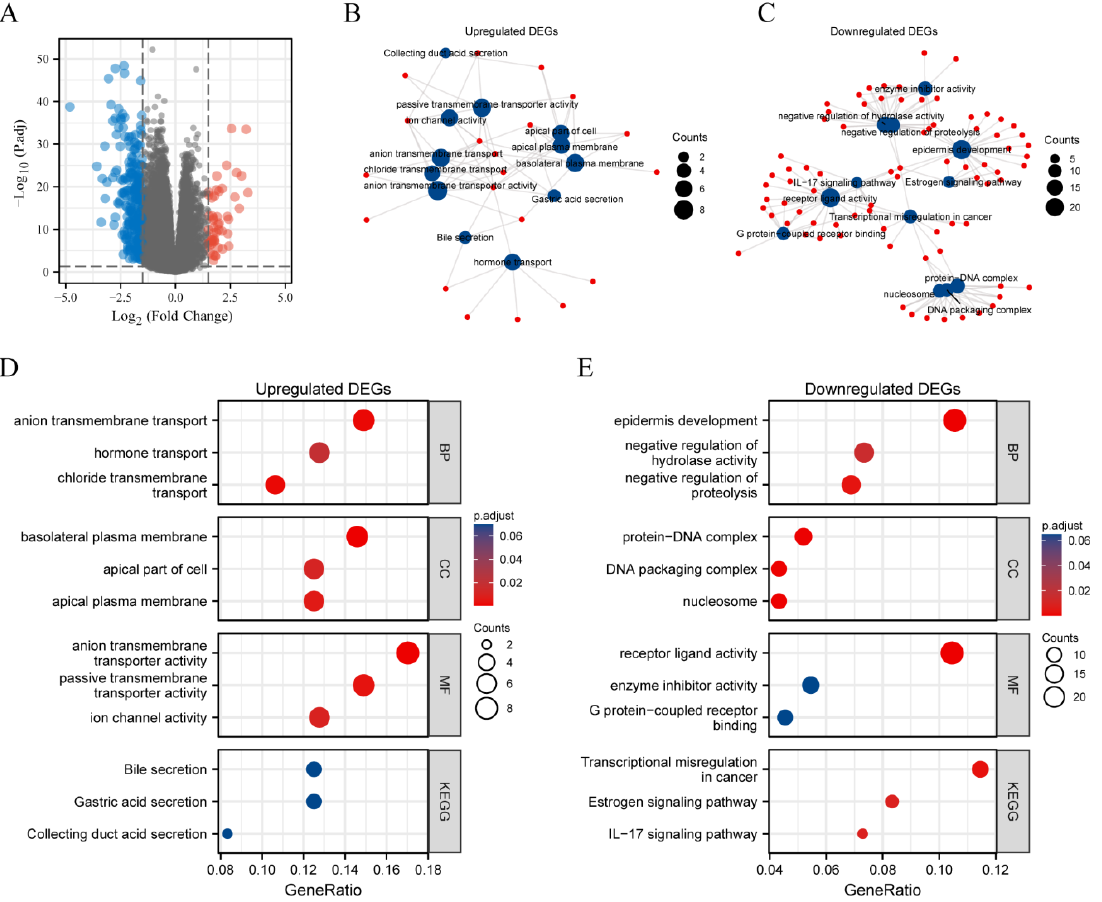
Figure 8. The volcano map and enrichment analysis of DEGs between METTL7A high- and low- expression groups in KIRC. ( A ) The volcano map of DEGs (red: upregulation; blue: downregulation); ( B , C ) Visual networks for enrichment analysis (red: molecular; blue: enrichment results); ( D ) GO and KEGG analysis of upregulated DEGs; ( E ) GO and KEGG analysis of downregulated DEGs.